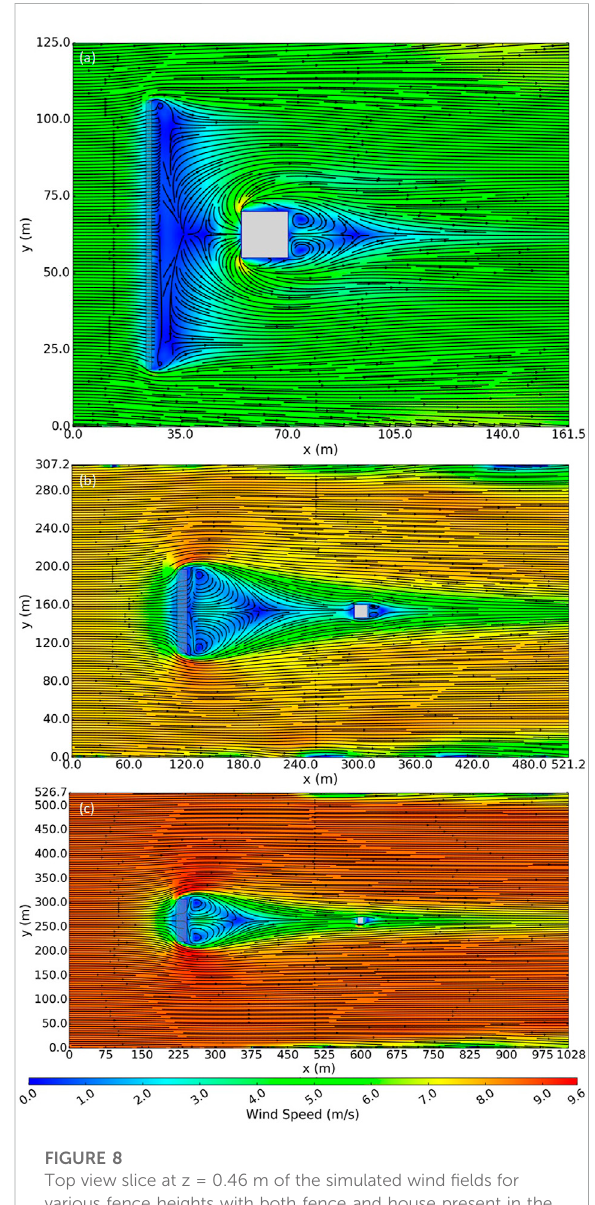
FIGURE 8 Top view slice at z = 0.46 m of the simulated wind fi elds for various fence heights with both fence and house present in the fl ow. Fence heights of (A) 1.8 m, (B) 11 m, and (C) 22